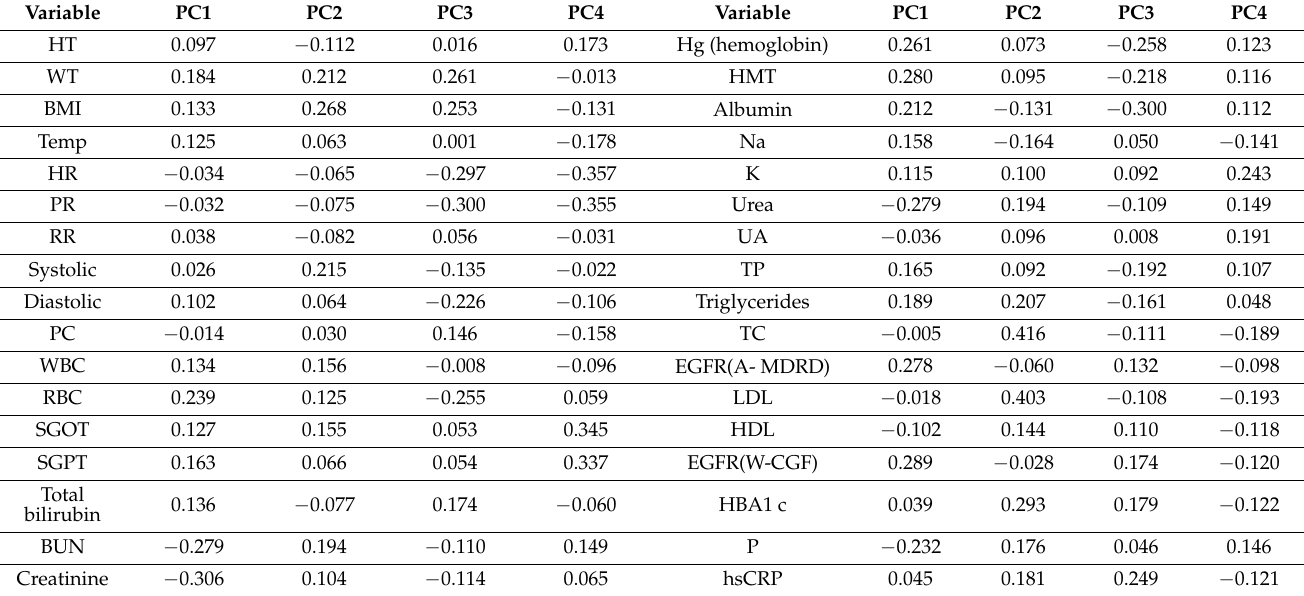
Table 7. Principal components for each variables.